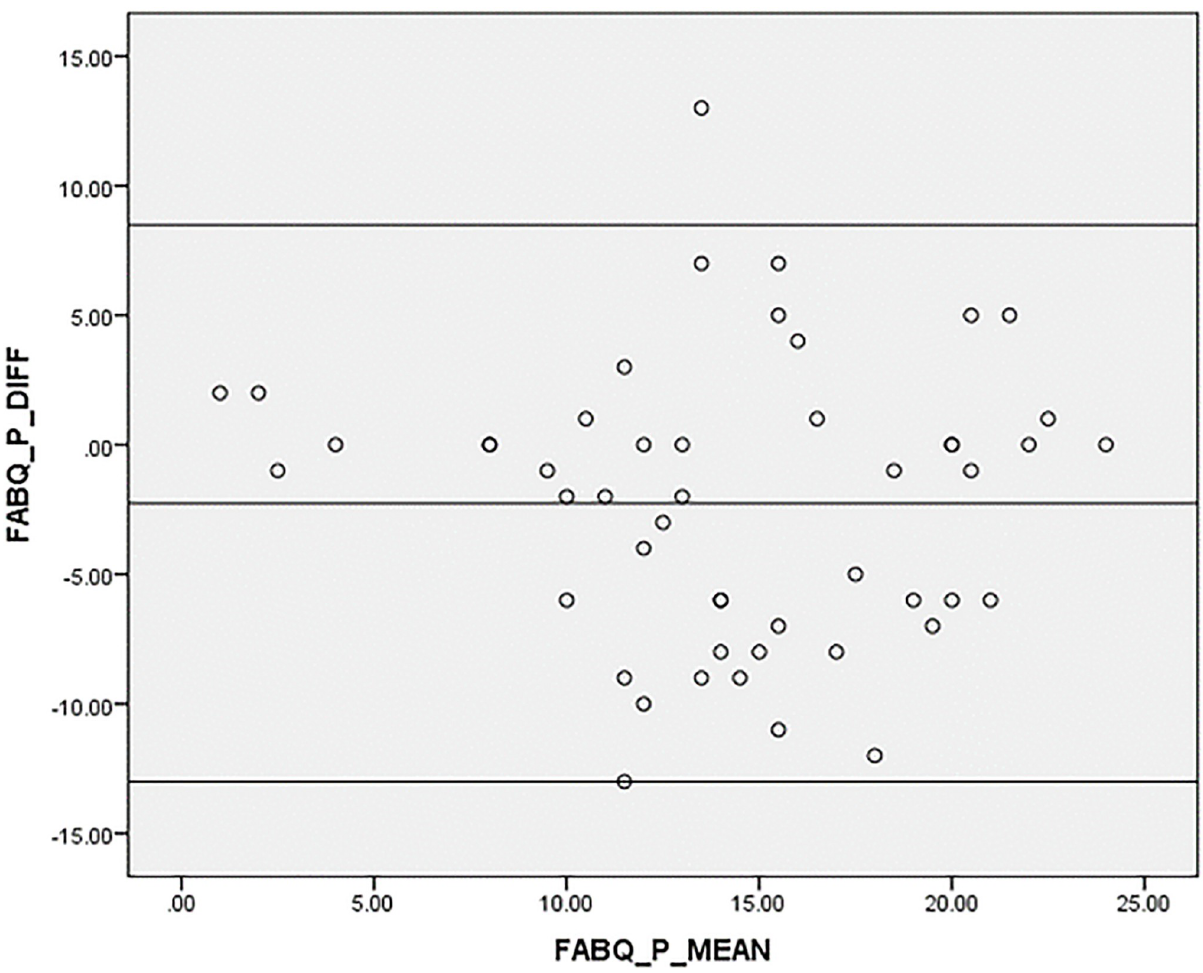
Fig 3. Bland-Altman plot for test-retest agreement of Igbo-FABQ (physical activity). [upper limit: (+1.96 SD): 8.48; mean: -2.26 (-3.81, -0.70); SD: 5.48; lower limit: (-1.96 SD): -13.00].